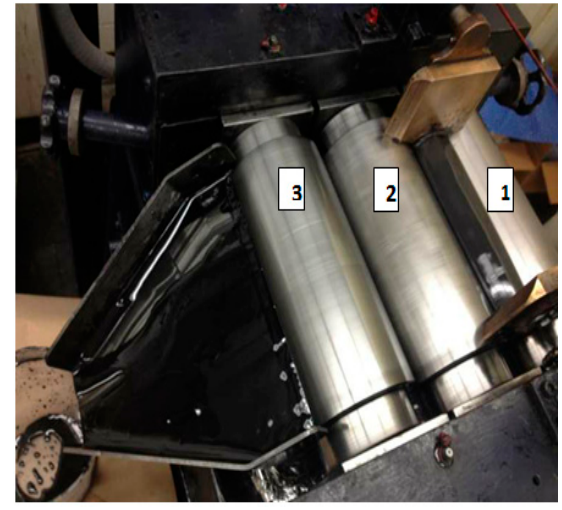
Figure 2. Lehmann Mills three-roll mixer.